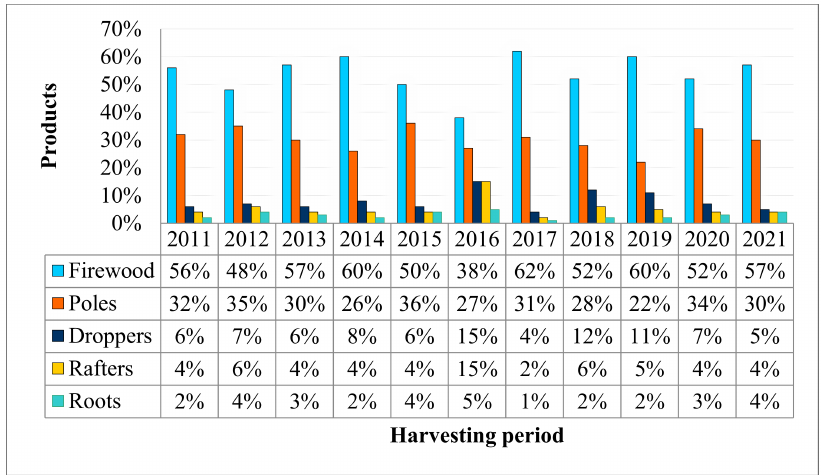
Figure 4. C. mopane products harvested per